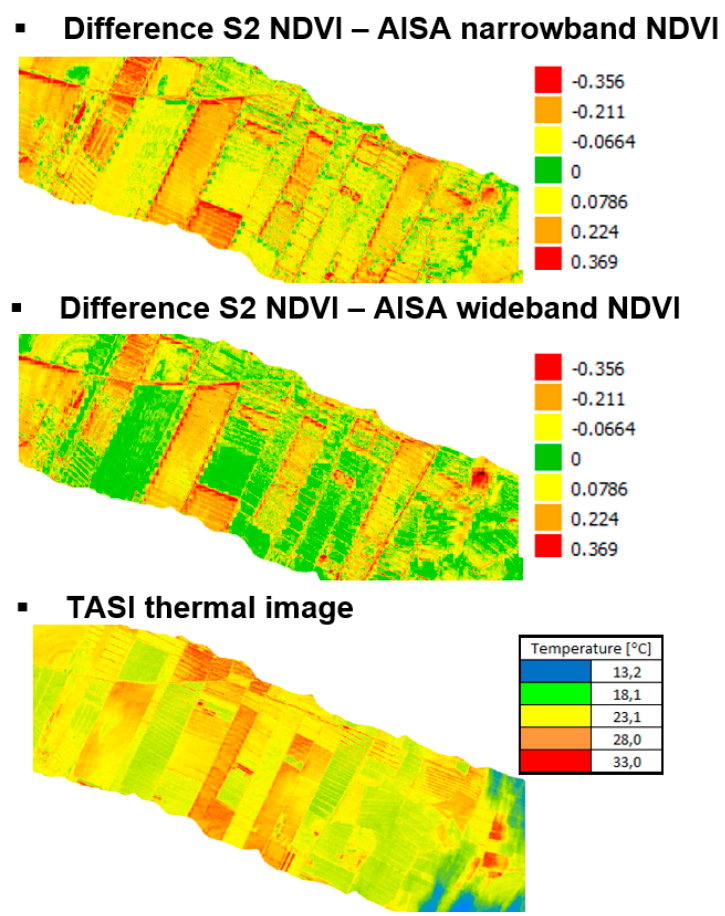
Figure 6. Example showing the difference between Sentinel-2 NDVI and AISA narrowband NDVI (top), and AISA wideband NDVI (middle panel). Bottom panel shows the TASI thermal image in [ ° C]. Region corresponds to yellow rectangle in Figure 5.